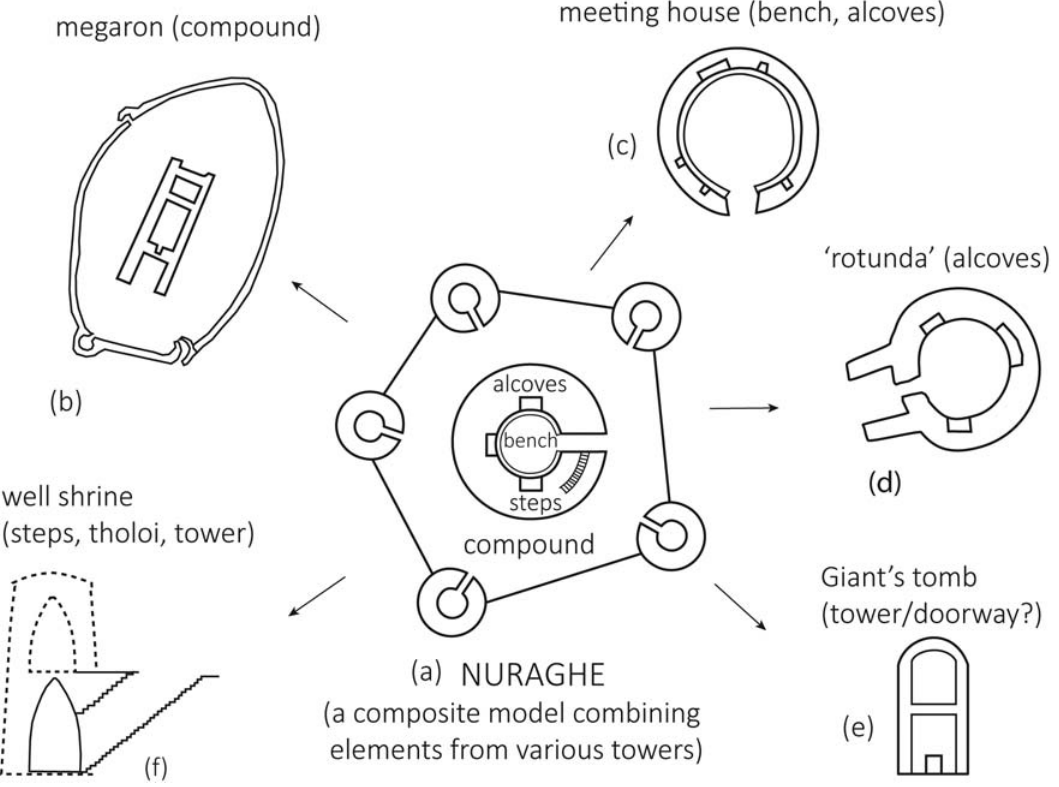
Figure 3: Architectural features of nuraghi ( in schematic form ) found in di ff erent types of ritual buildings: ( a ) nuraghe, composite model; ( b ) megaron ( Fadda, 2017, p. 242 ) ; ( c ) meeting house ( Moravetti, 2017b, p. 151 ) ; ( d ) rotunda ( Moravetti et al., 2017, p. 408 ) ; ( e ) Giant ’ s tomb ( Melis, 2017, p. 75 ) ; and ( f ) well shrine ( Salis, 2017, p. 269 )